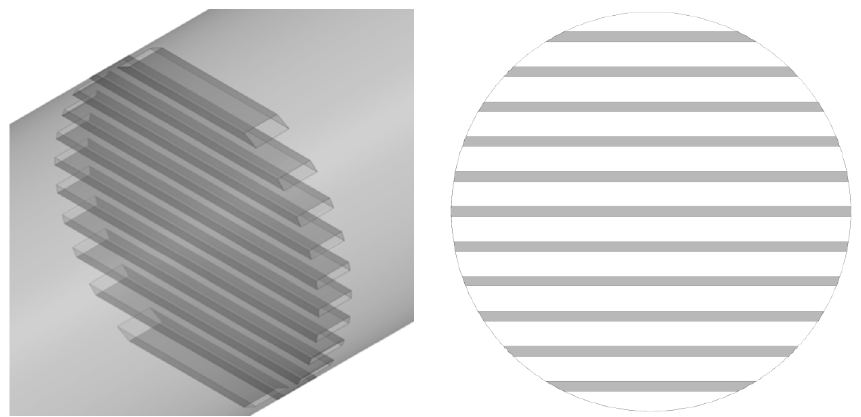
Figure 4. Mesh partition construction.